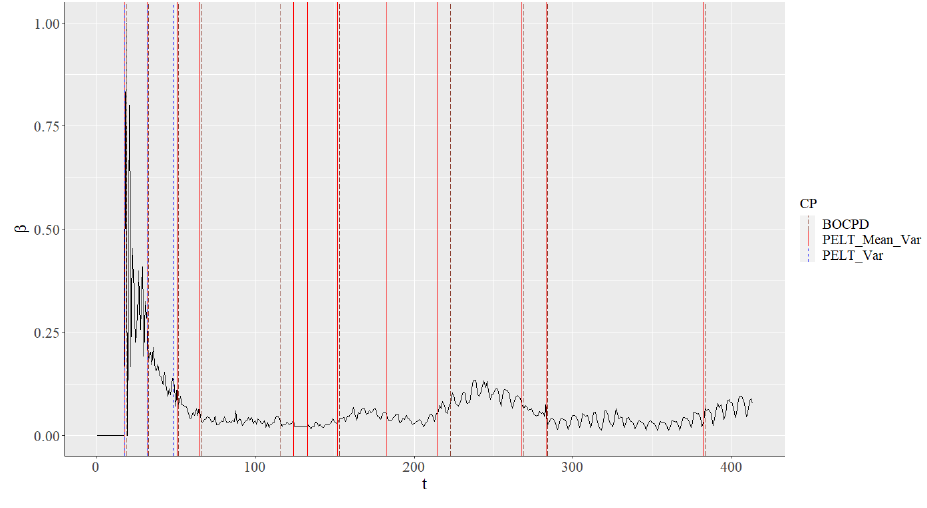
Figure 9. Detection of CPs in the COVID-19 transmission rate ( BOCPD ( m ) = 10, PELT _ Mean _ Var ( m ) = 12, PELT _ Var ( m ) =